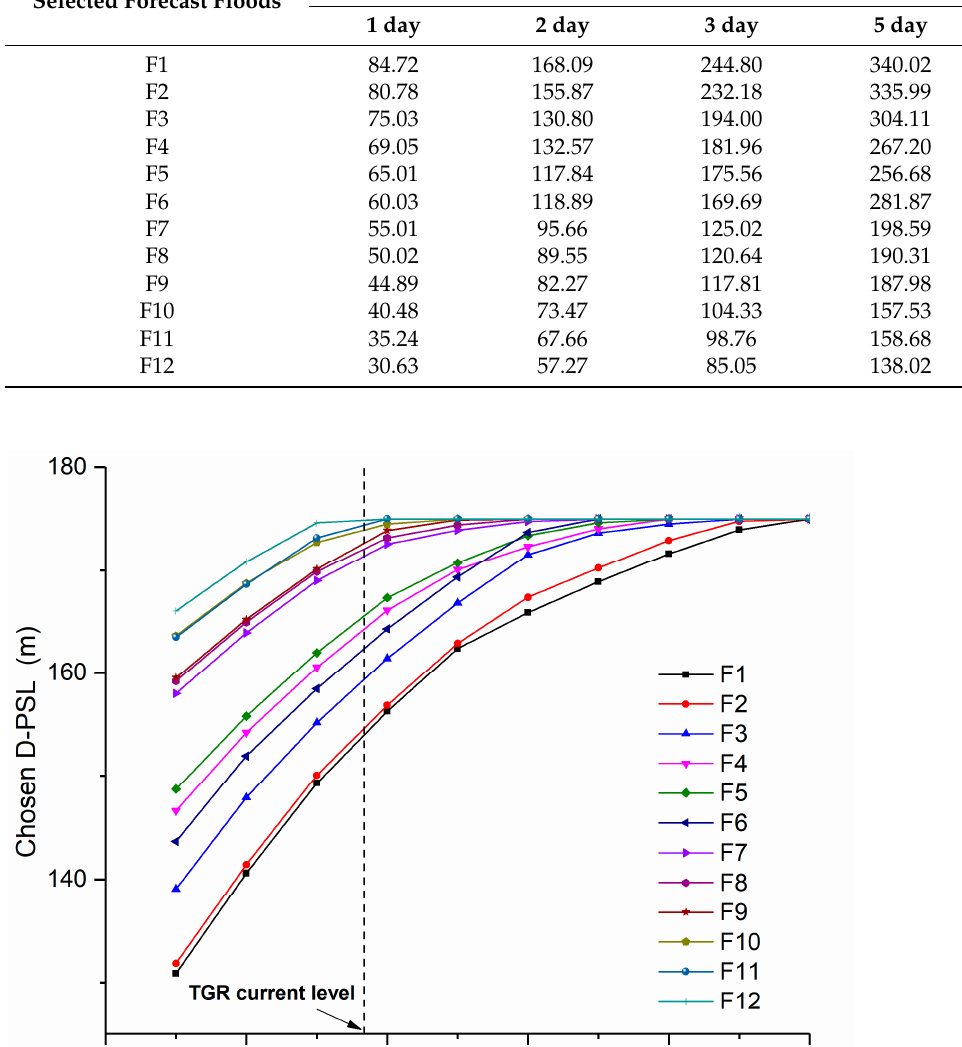
Figure 7. The relationship between chosen D-PSL and downstream conveyance capacity ( r t for 12 selected forecast floods under moderate forecast skill, the vertical dashed line represents the current TGR conveyance capacity of 56,700 m 3 /s.